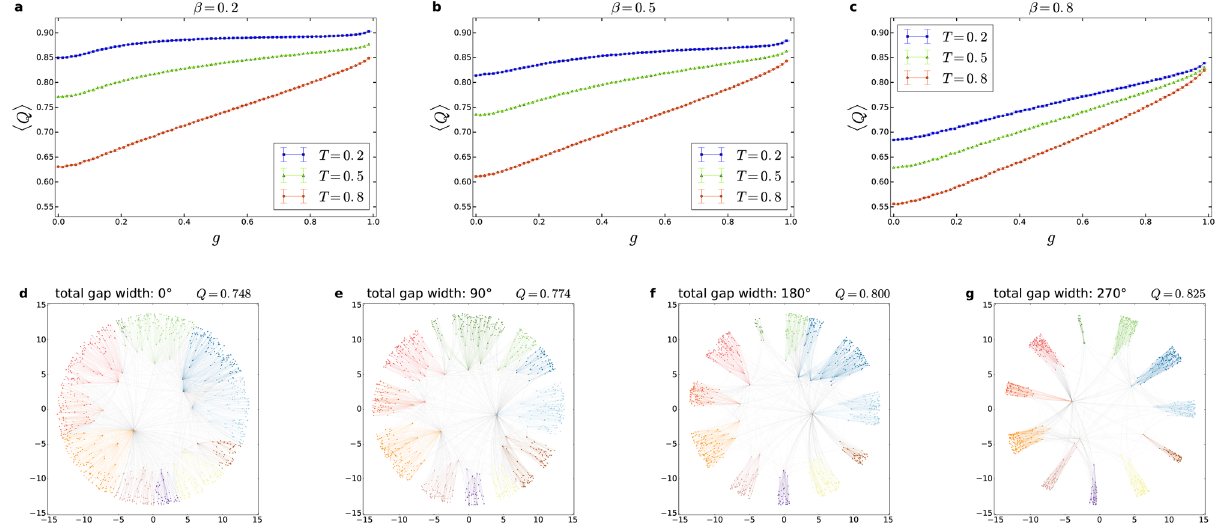
Figure 8. Transition to non-uniform angular node distribution in the case of the PSO model. The weighted modularity Q averaged over 100 networks of size N as a function of the relative gap size g between the modules for β 0.8 in ( c ). (The error bars indicate the 95% confidence intervals.) In ( d – g ), we show a series of network β = layouts at increasing gap widths for N communities found by the Louvain